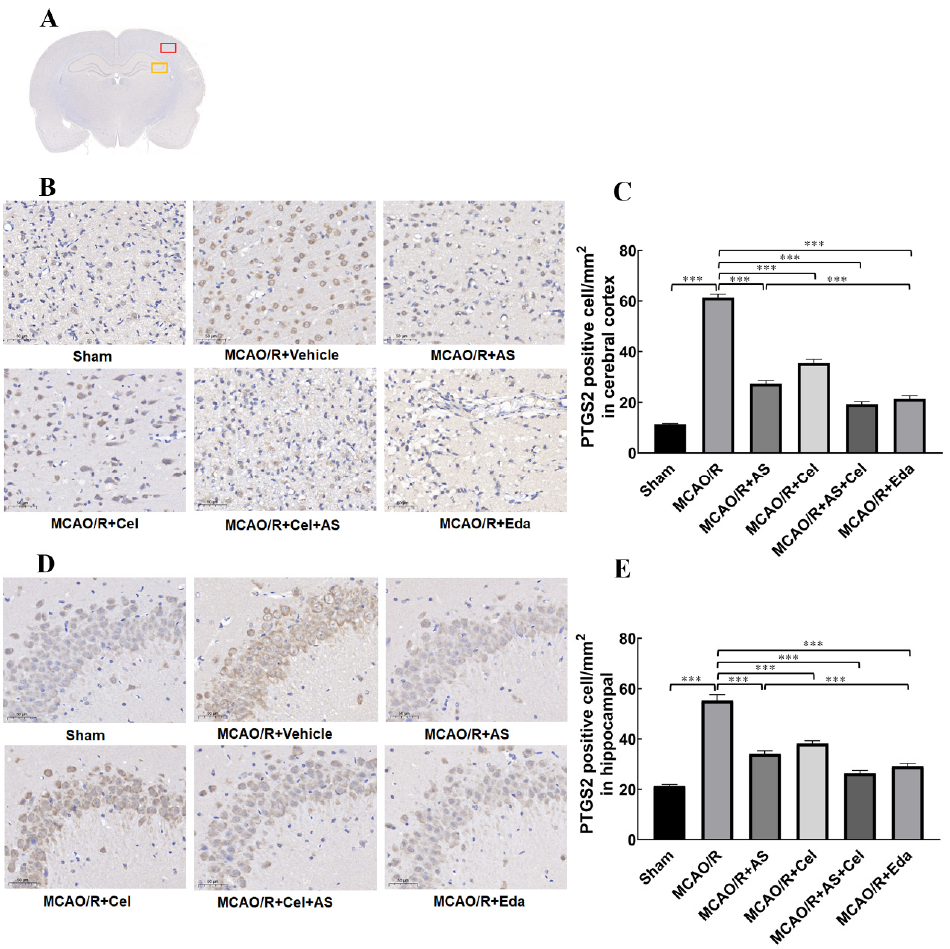
Figure 5. AS treatment inhibited the expression of PTGS2. ( A ) The observation areas in the cortex (red) and hippocampus (yellow). ( B ) The immunohistochemical staining (400 × ) of PTGS2 in the cortex and ( C ) quantitative analysis. ( D ) The immunohistochemical staining (magnification was 400 × ) of PTGS2 in the hippocampus and ( E ) quantitative analysis. (n = 3 rats for each group). Data are expressed as the mean ± SD, *** p < 0.001. ns stands for no statistical